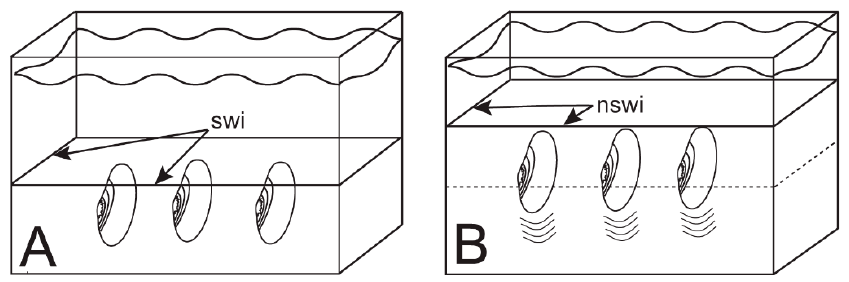
Figure 8. Experimental setup. ( A ) Three animals in life position at start of burrowing test. swi—original sediment water interface; ( B ) Animals burrowing upward to escape addition of new sediment. nswi—new sediment water interface.